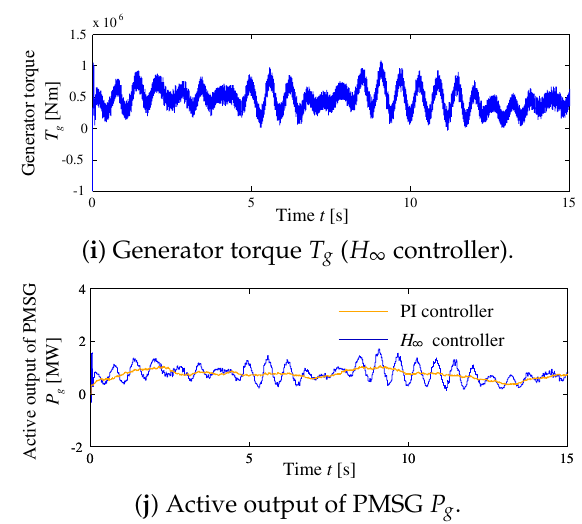
Figure 16. Simulation results in Proportional-Integral (PI) control and H ∞